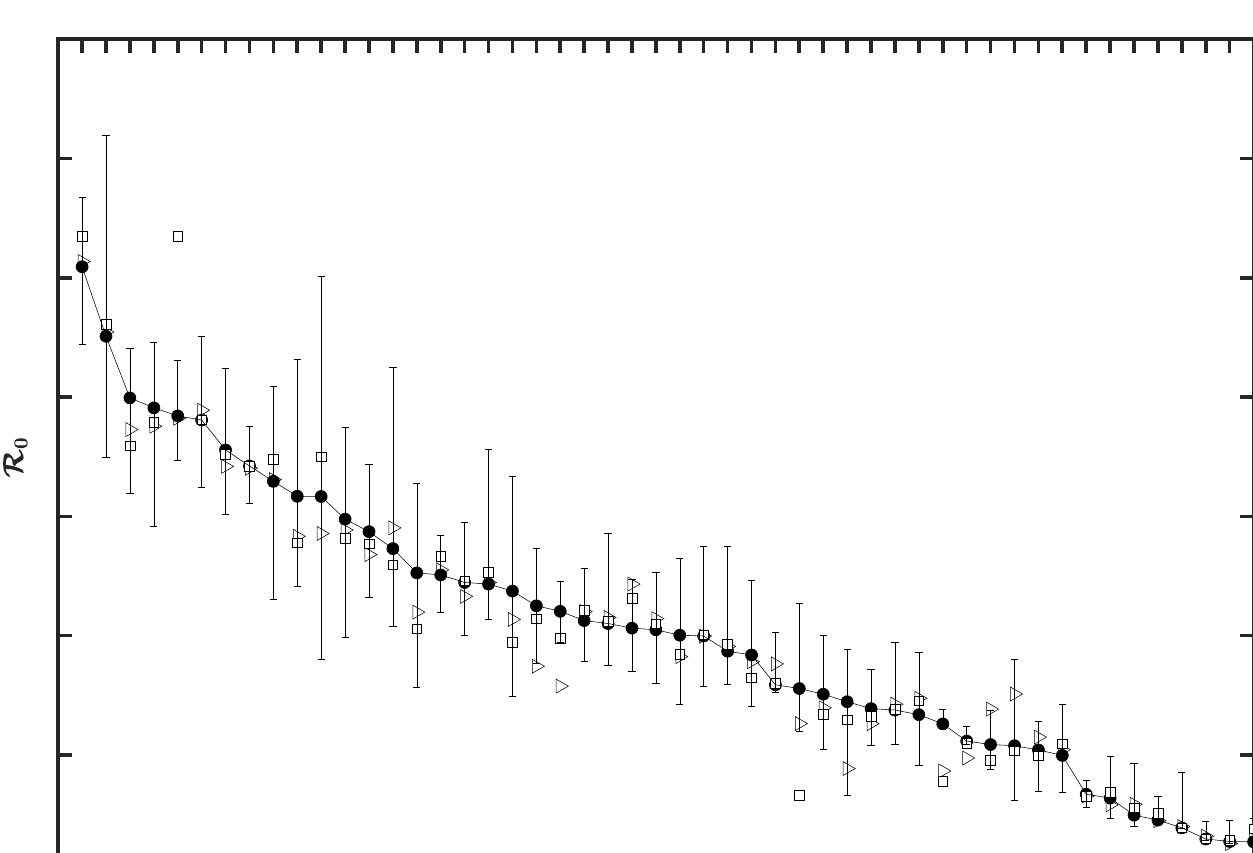
Figure 4. Onset times of COVID-19 disease transmission for ancestral strains of SARS-CoV-2 in all 50 US states. The onset time 𝜎 is defined as the first day on which the cumulative reported case count was 200 cases or more. Dates corresponding to 𝜎 values on the vertical axis are indicated above each bar. States are indicated using two-letter US postal service state abbreviations ( https://about.usps.com/who-we-are/postal-history/state-abbreviations.pdf (accessed on 19 September 2021 )).